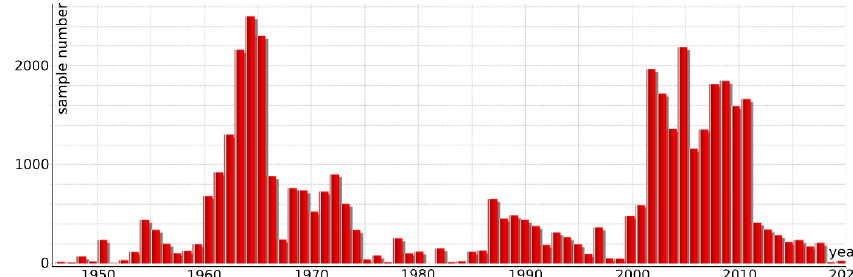
Figure 5. Temporal distribution of approximately 45000 surface sediment samples within the EEZ.